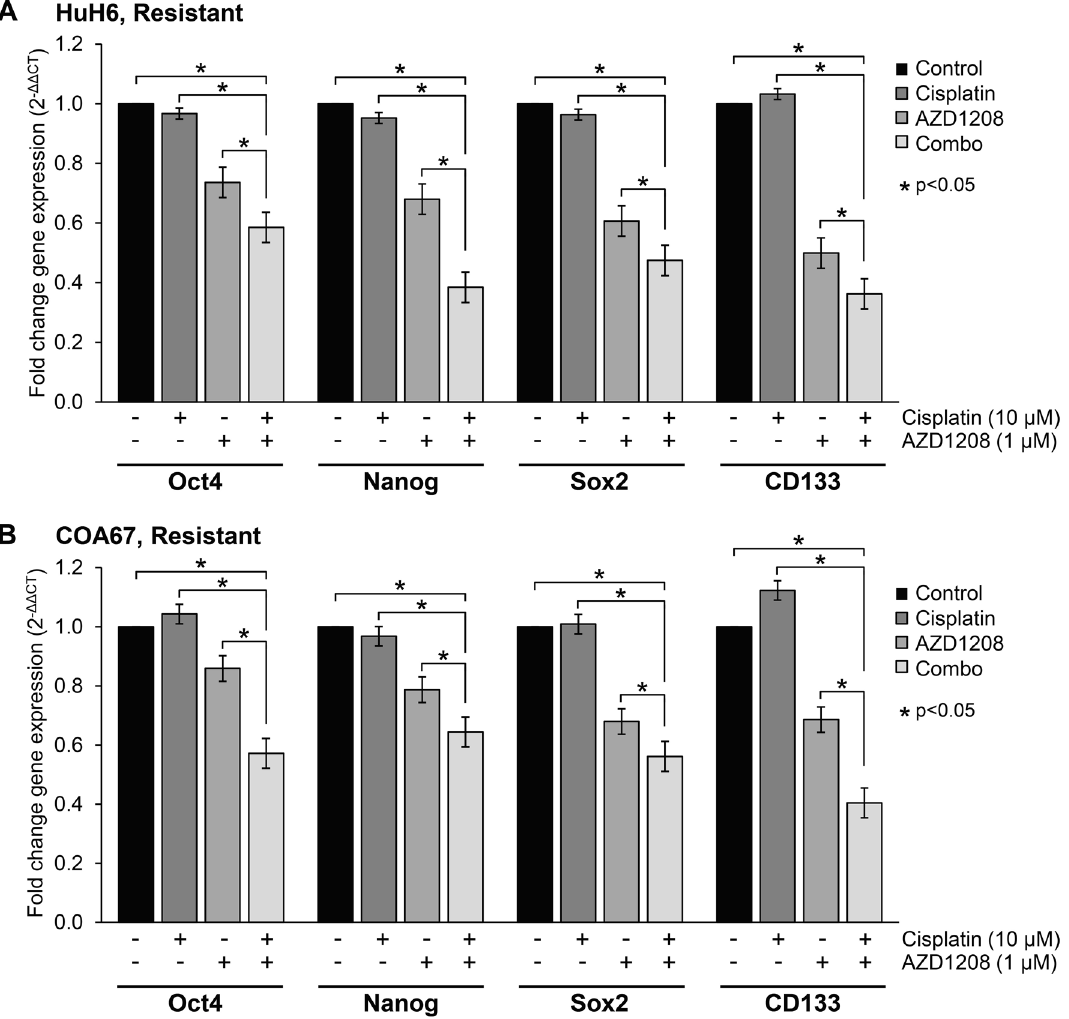
Figure 6. AZD1208 combined with cisplatin downregulates gene expression of known stem cell-like cancer cell (SCLCC) markers in cisplatin-resistant hepatoblastoma cells. ( A ) HuH6 and ( B ) COA67 cisplatin-resistant cells were treated with 1 µM of AZD1208, 10 µM of cisplatin, or both drugs for 72 h, and quantitative real-time PCR was utilized to assess the mRNA abundance of Oct4, Nanog, Sox2, and CD133. Relative abundance of mRNA was calculated using the ΔΔCt method and reported as mean ± SEM of three biologic replicate experiments. Cisplatin treatment did not affect mRNA abundance of the stem cell markers Oct4, Nanog, and Sox2 and upregulated the gene expression of CD133. Treatment with both AZD1208 and cisplatin significantly decreased mRNA abundance of the stem cell markers Oct4, Nanog, Sox2, and CD133 in both ( A ) HuH6 and ( B ) COA67 cisplatin-resistant cells compared to cisplatin or AZD1208 alone, or to untreated controls (p <